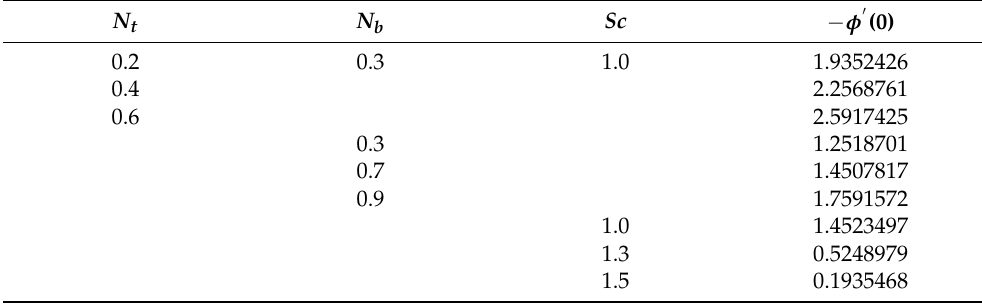
Table 5. The effect on the Sherwood number Re x 1 2 Sh x = − φ (cid:48) ( 0 ) . with the microorganism of different physical parameters.